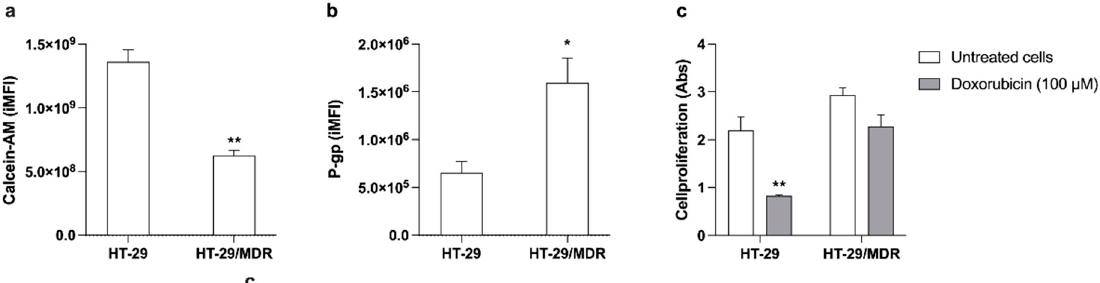
Figure 8. Assessment of the multi-drug-resistant phenotype in HT-29/MDR cells. ( a ) Cellular internalization of a P-gp substrate expressed as the integrated mean fluorescence intensity (iMFI) of calcein-AM, as detected by cytofluorimetric analysis in HT-29 and HT-29/MDR cells. Statistically significant difference versus HT-29 cells: ** p ≤ 0.01 ( n = 3). ( b ) Pg-p expression by cytofluorimetric analysis in HT-29 and HT-29/MDR cells. Statistically significant difference versus HT-29 cells: * p ≤ 0.05 ( n = 3). ( c ) Cell proliferation was evaluated by WST-1 assay after 48 h of doxorubicin (100 μ M) incubation. Statistical significance versus untreated cells: ** p ≤ 0.01 ( n = 2).